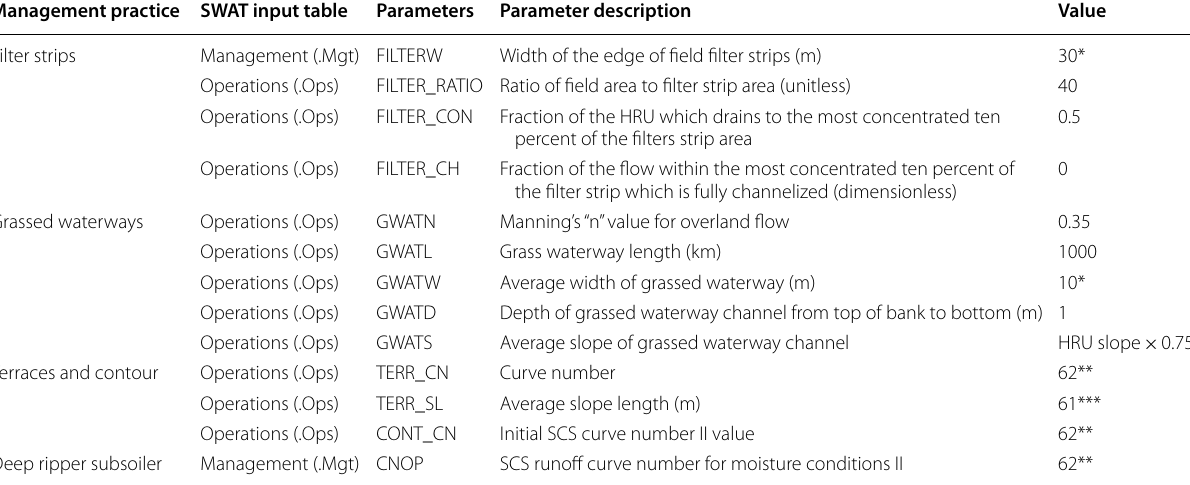
Table 4 List of SWAT input parameters and values used for each management practice Management practice SWAT input table